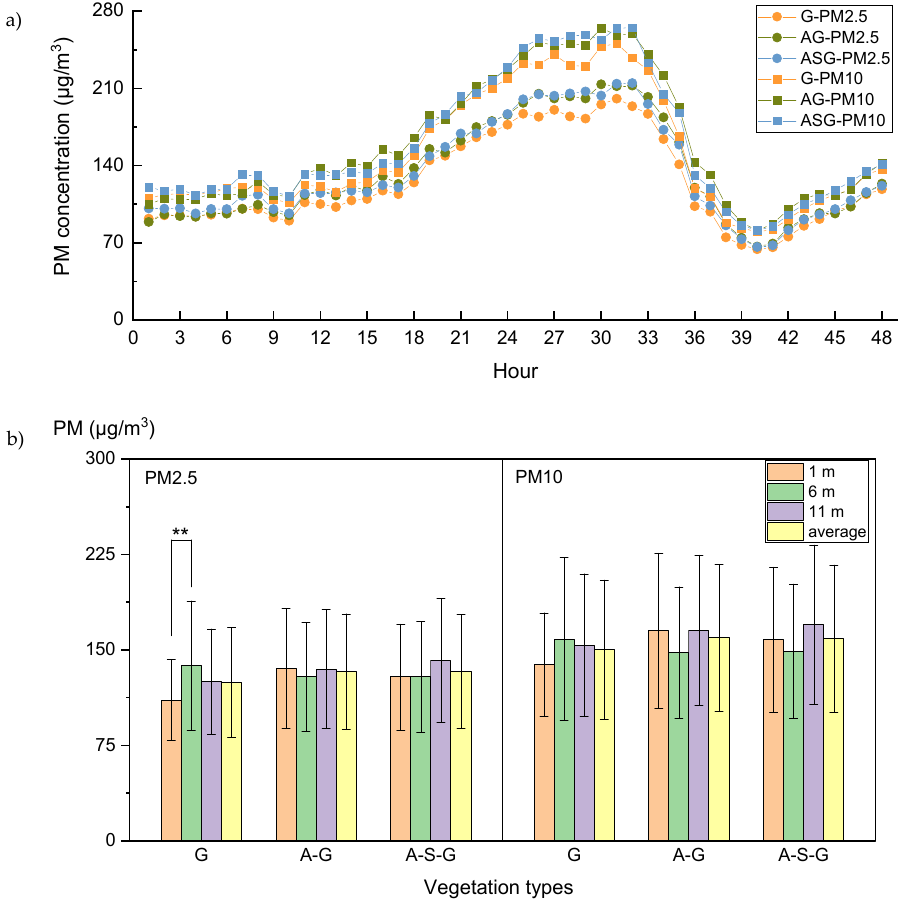
Figure 2. ( a ) Hourly trends in the average PM 2.5 and PM 10 concentrations within the three vegetation types: open grassland (G), arbor-grass woodland (AG) and arbor-shrub-grass woodland (ASG); ( b ) ANOVA results for the PM 2.5 and PM 10 concentrations in different vegetation types and distances from the river across the entire observation period. ** p ≤ 0.01; Error bar: standard deviation.